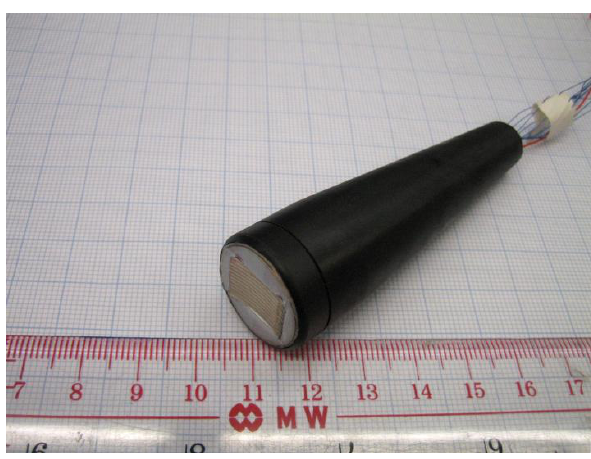
Figure 19. Photography of as-fabricated cylindrically shaped ultrasonic linear